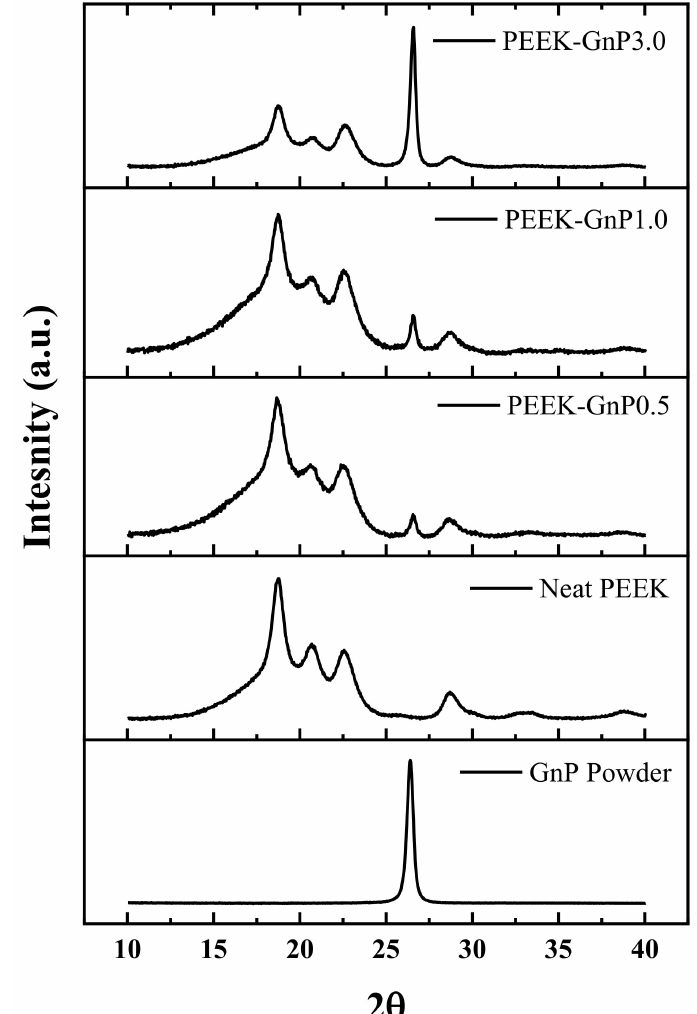
Figure 5. XRD patterns of the neat PEEK and GnP-filled PEEK